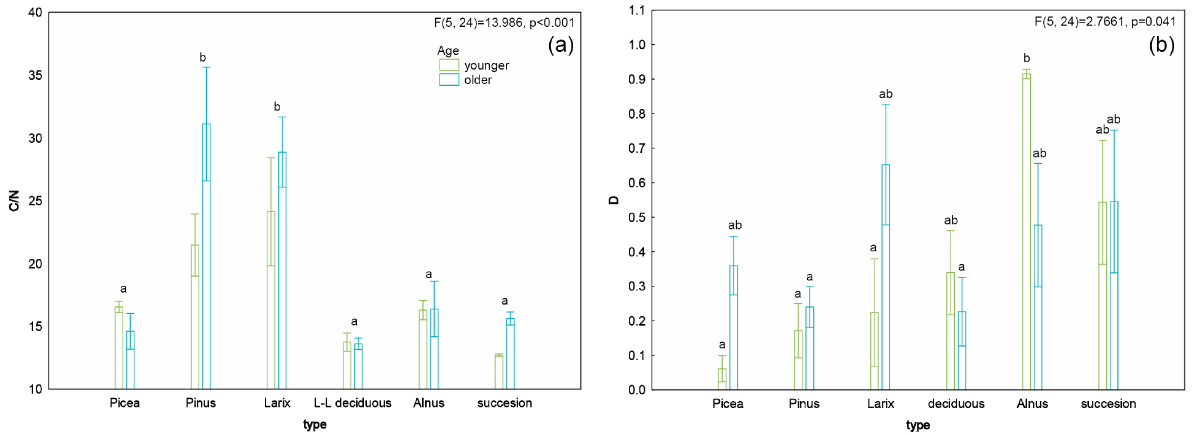
Figure 6. Results of factorial ANOVA. ( a ) C/N ratio, ( b ) D—Simpson’s diversity index. Error bars indicate standard errors, and bar height is the mean value. Categories on the X-axis show stand type in two age categories (younger—green, older—blue). The letters indicate significant differences based on the post hoc Tukey test, assuming p < 0.05.